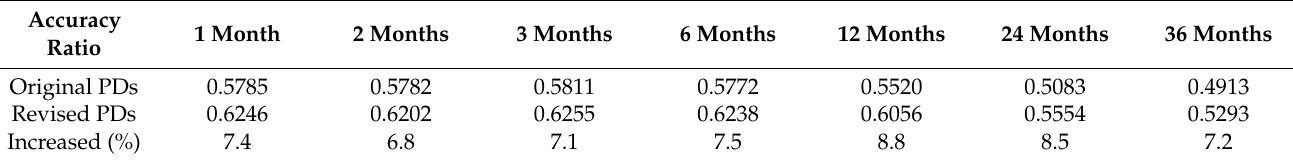
Table 6. Comparison of the ARs in the sample.